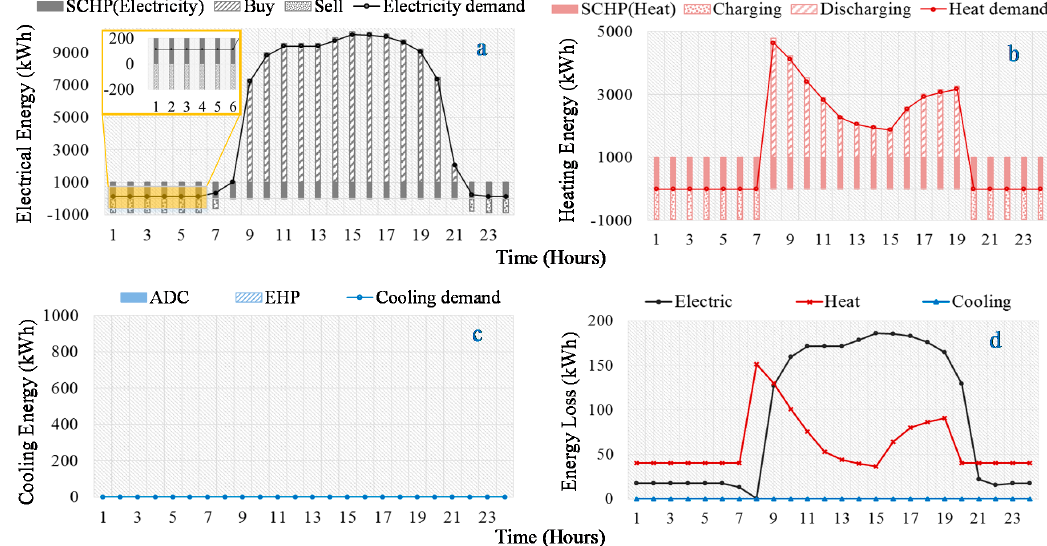
Figure 11. Energy balancing of BMG2 in winter season: ( a ) electrical energy; ( b ) heating energy; ( c ) cooling energy; and ( d ) energy loss.